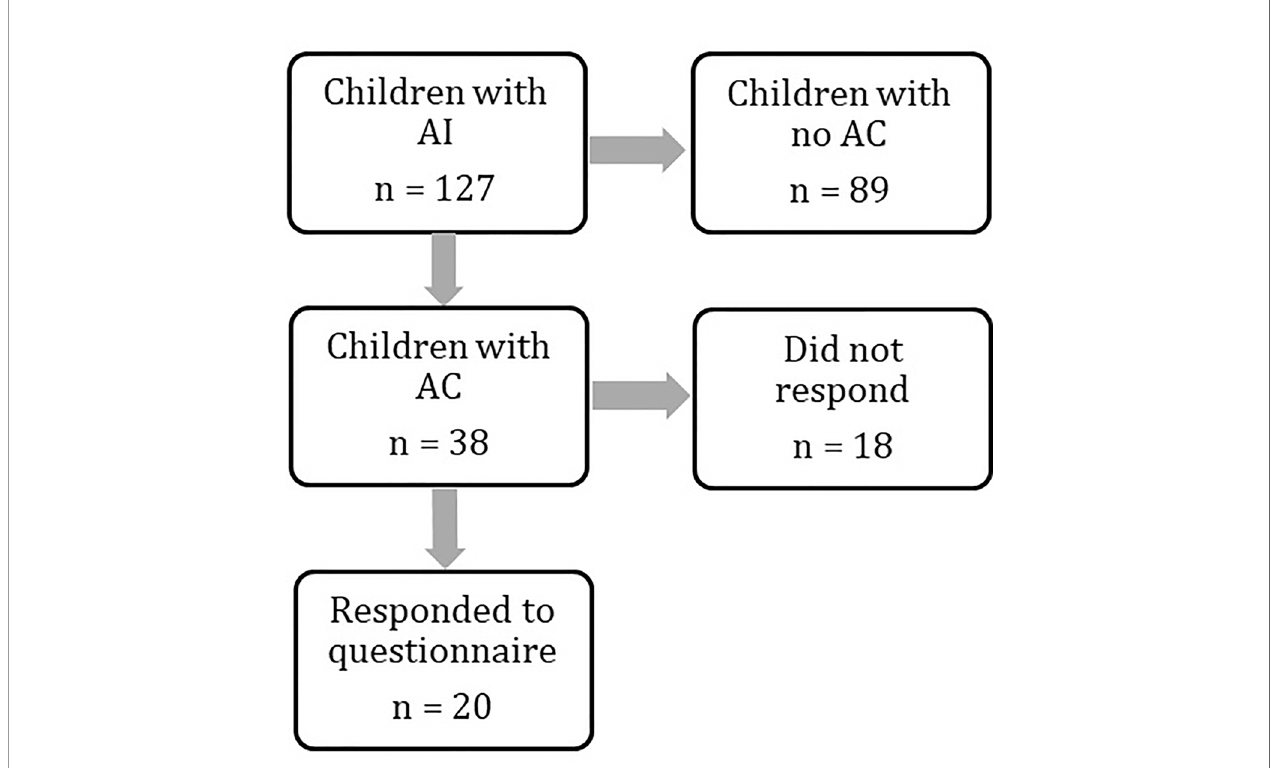
FIGURE 1 | Flowchart demonstrating numbers of patients identi fi ed at each stage of the study. Patient groups were compared at every stage to assess for differences. Results are provided in the manuscript and Tables 1 and 2